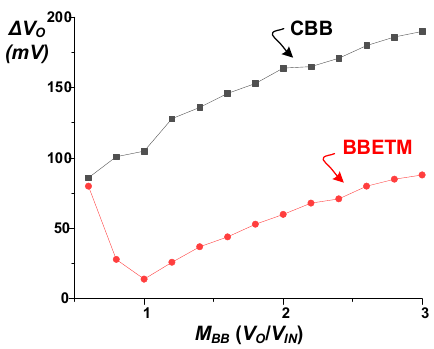
Figure 19. Simulated output voltage ripple plot of the BBETM and CBB across different conversion ratios.